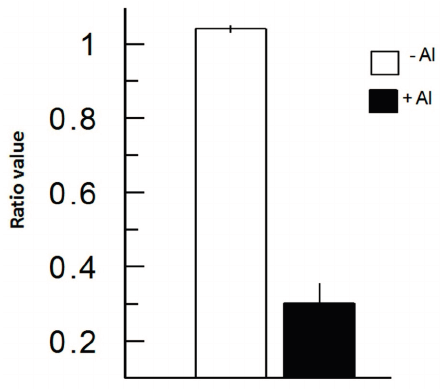
Figure 4. The elongation region depicts dramatic decreases in intracellular H 2 O 2 levels. Intracellular H 2 O 2 levels were measured in several Arabidopsis roots before and after treatment with 1 mM Al. Note that the elongation region exhibits a dramatic decrease in ratio signal after 30 min of Al treatment. n = 25